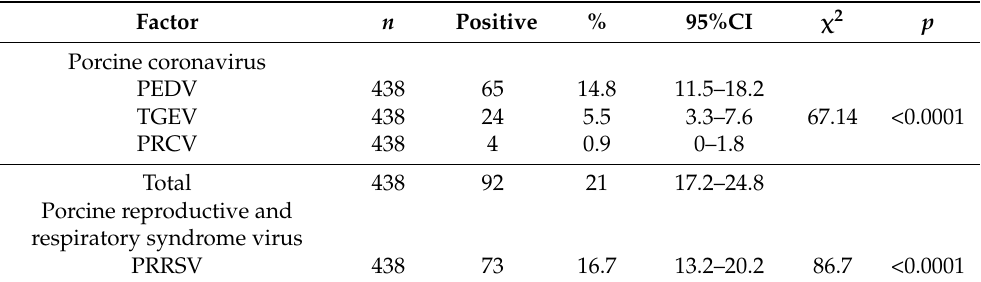
Table 1. Seroprevalence of porcine and reproductive syndrome virus and three different porcine